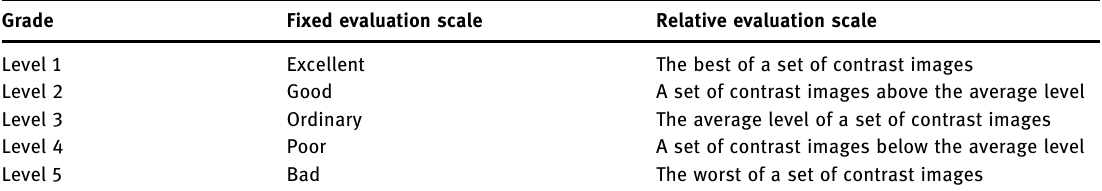
Table 1: Measurement and evaluation of the image detail enhancement e ff ect